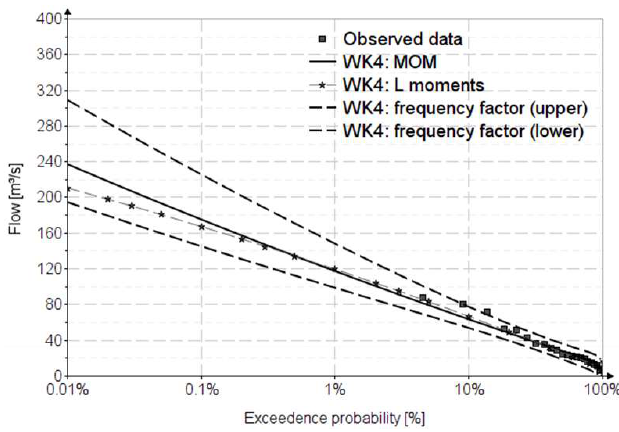
Figure 12. Wakeby distribution.